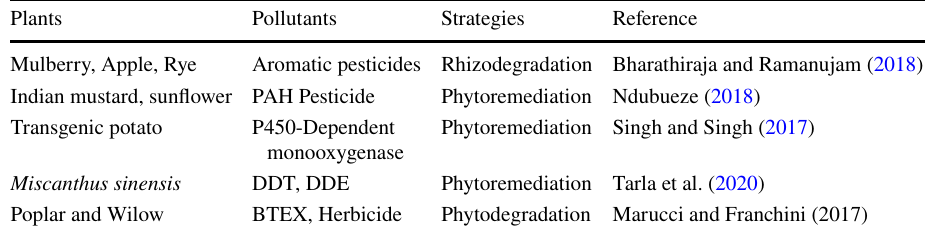
Table 5 Phytoremediation of pesticides